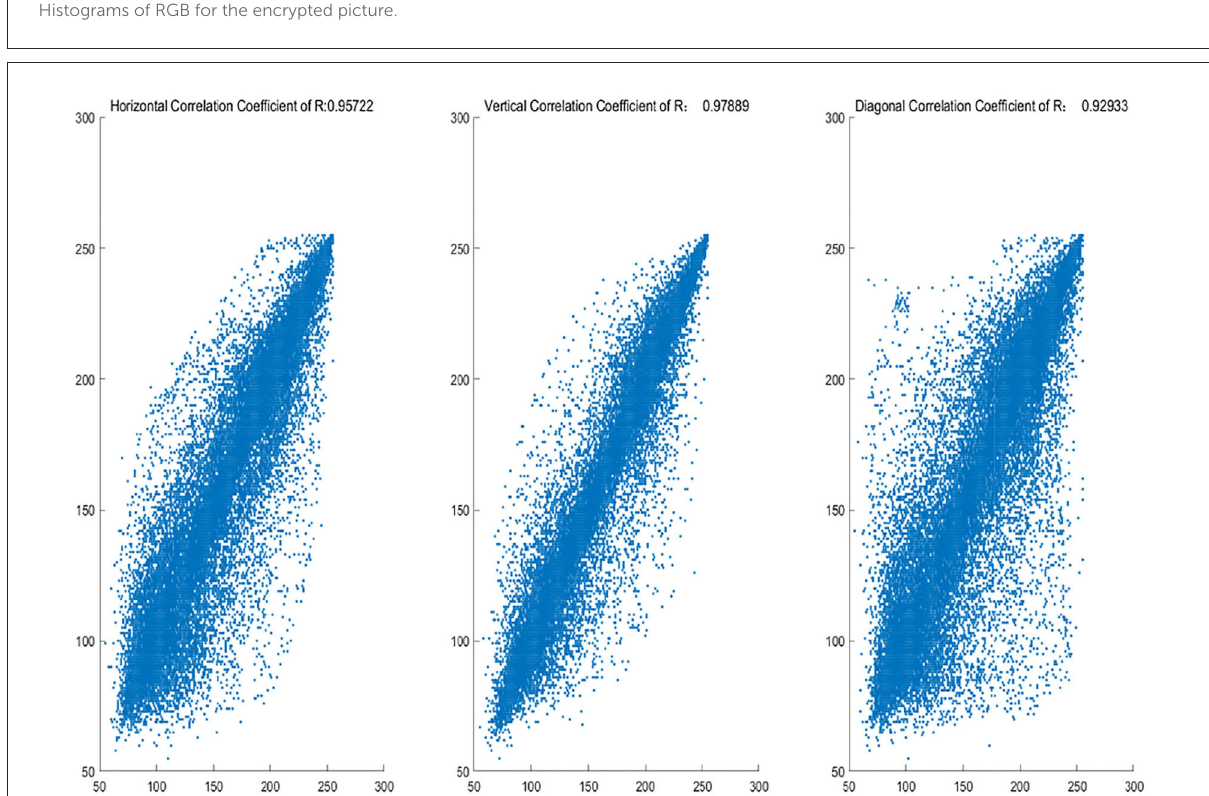
FIGURE13 R-channel correlation coefficients of the original image (From left to right: Horizontal Correlation Coefficient of R: 0.95722; Vertical Correlation Coefficient of R: 0.9789; Diagonal Correlation Coefficient of R: